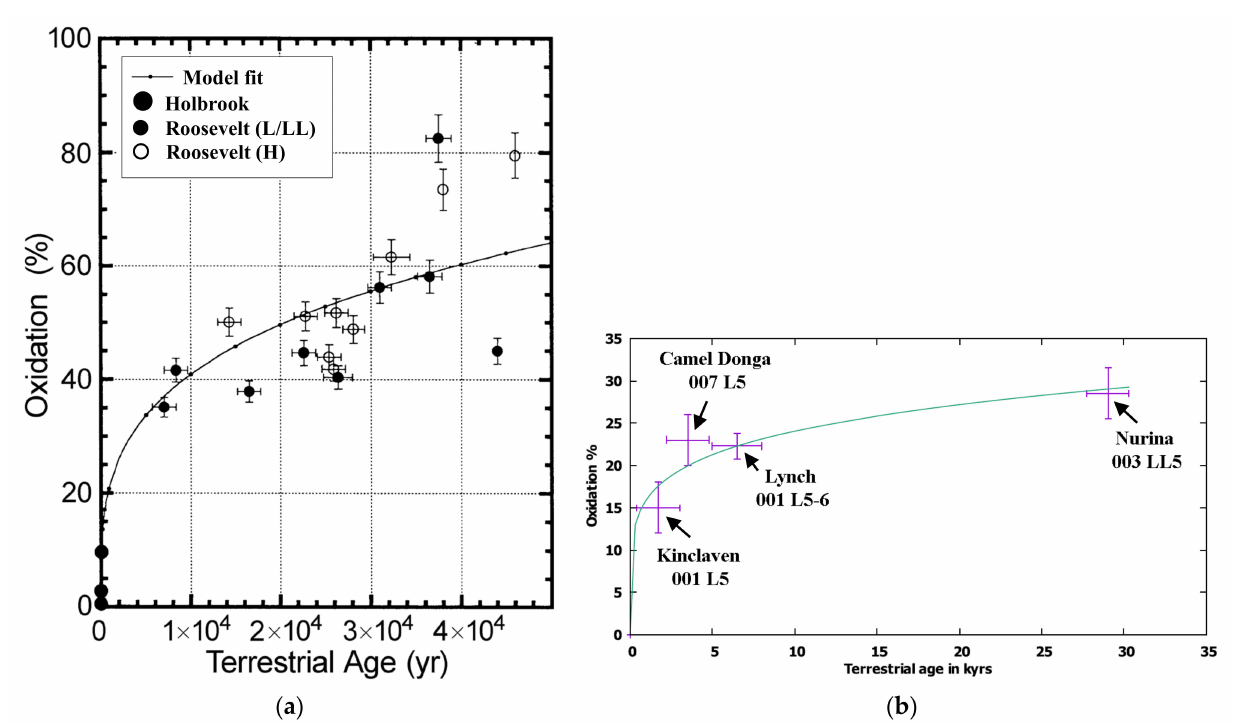
Figure 50. The plots of oxidation vs. terrestrial age for ordinary chondrites found in the Roosevelt County, New Mexico, USA ( a ) and in the Nullarbor Plain region of Western Australia ( b ). Fitting was done using the power law. Oxidation was determined by Mössbauer spectroscopy while terrestrial age was estimated using 14 C. Adapted from References